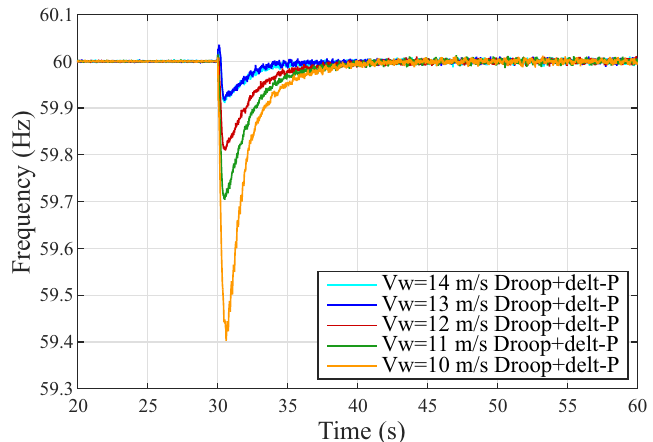
Figure 14. Frequency nadir as a function of wind speed.